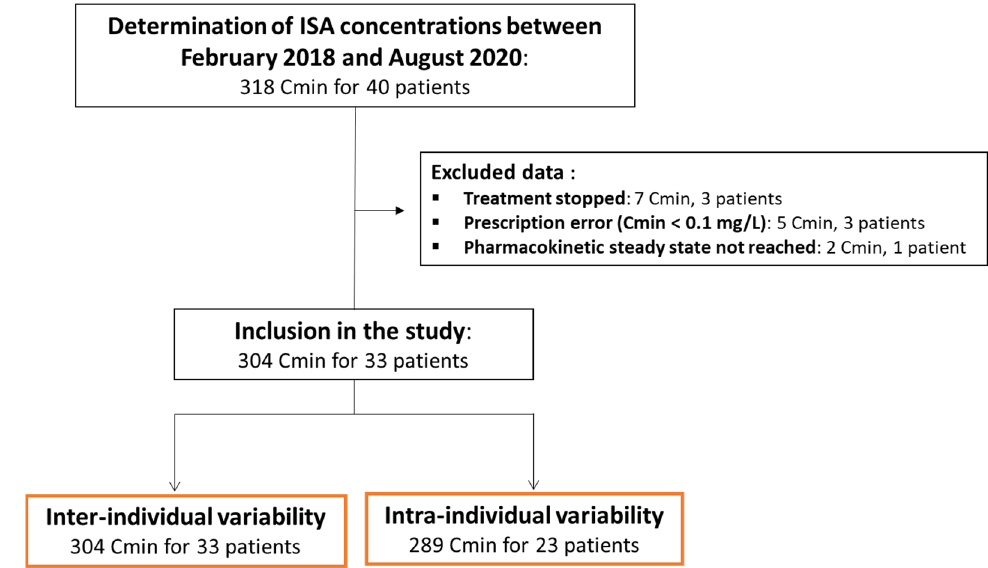
Figure 1. Flow chart. Figure 1. Flow Table 1. Patient characteristics.